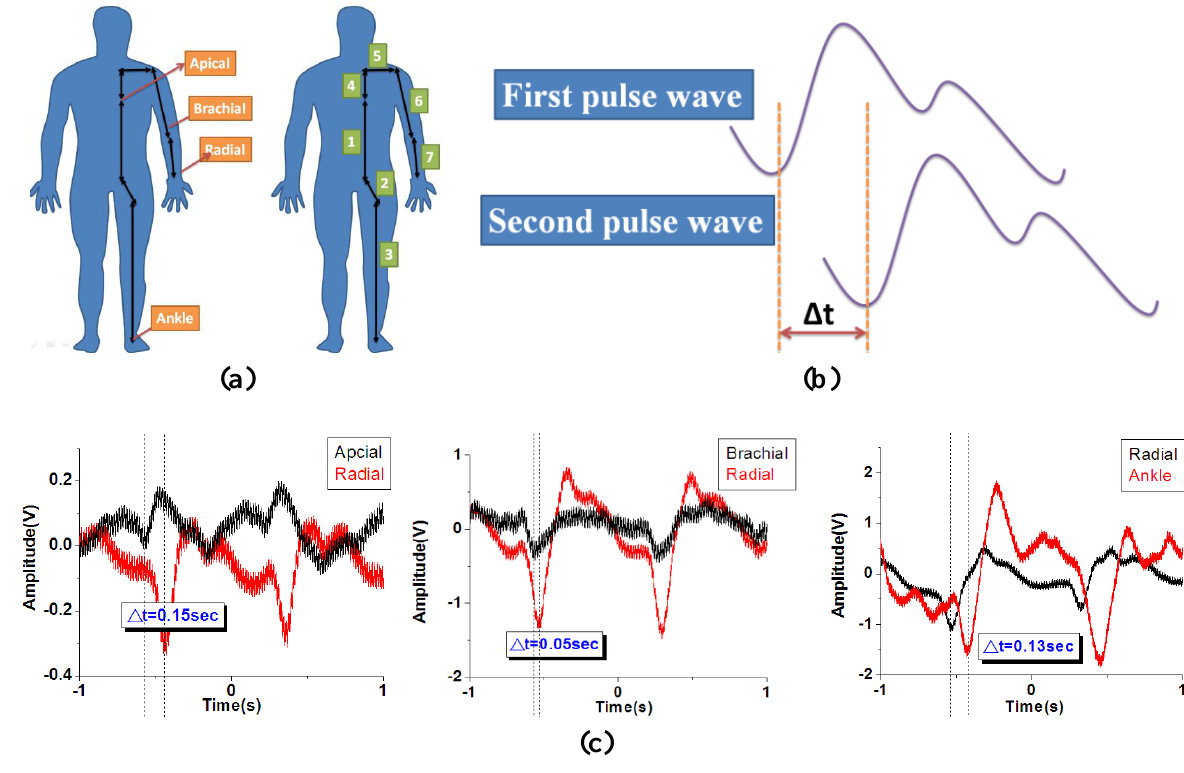
Figure 10. ( a ) PWV definition of the distance from apical to radial, brachial to radial and radial to ankle distance ( b ) The human body PWV calculation ( c ) the time interval between the apical to radial, brachial to radial and radial to ankle.